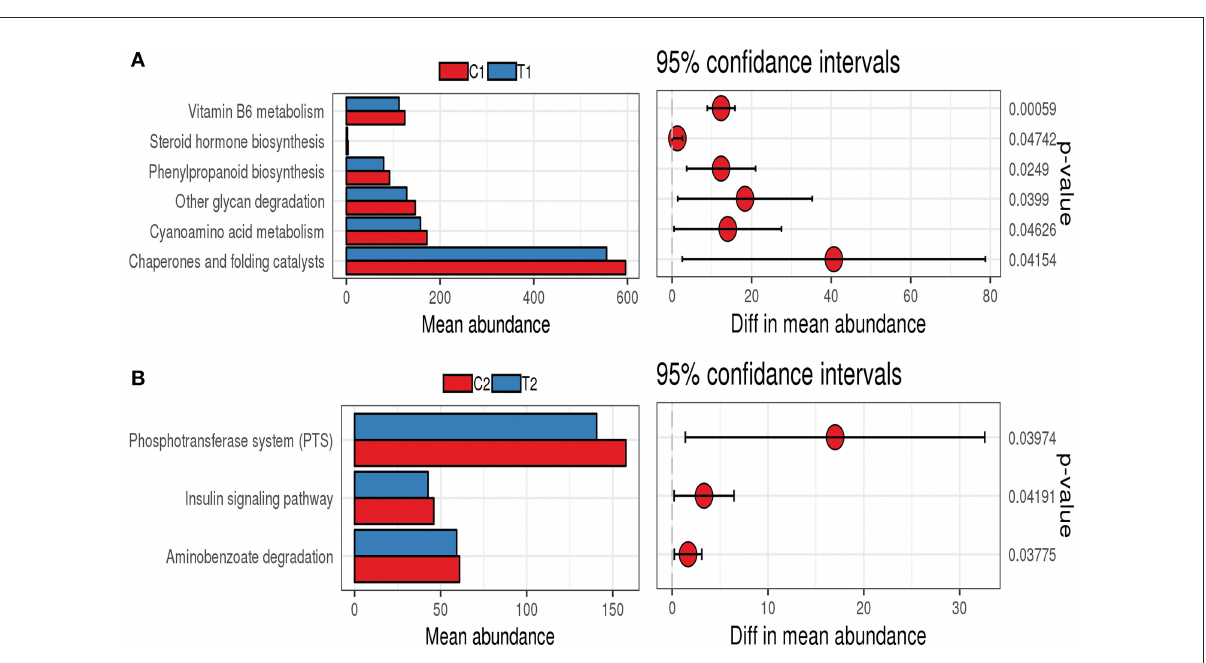
FIGURE8 PICRUSt function prediction chart. (A) Cecum; (B)